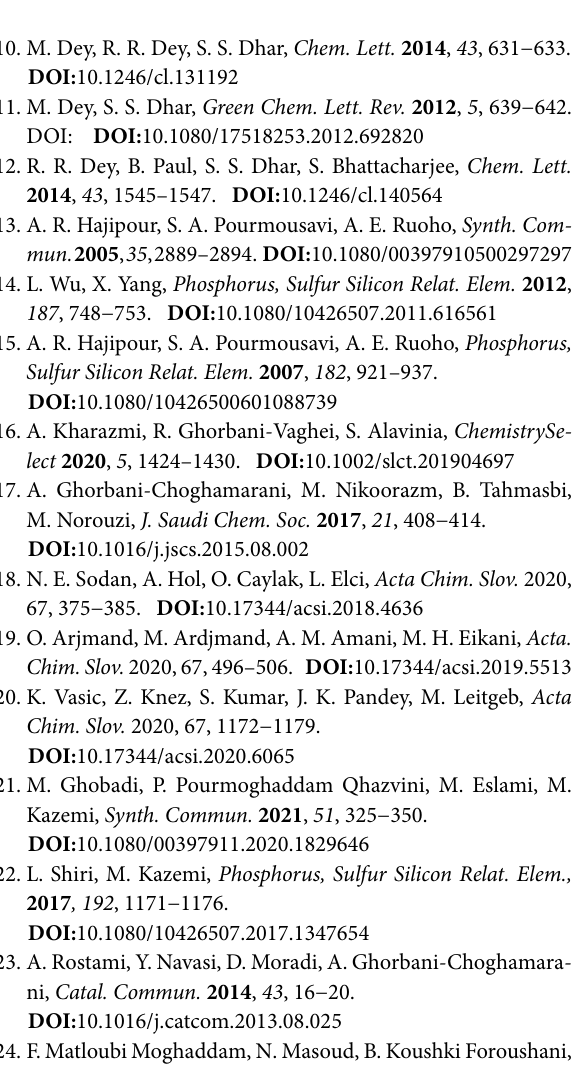
Tabari et al.: Magnetic Nanoparticles Linked